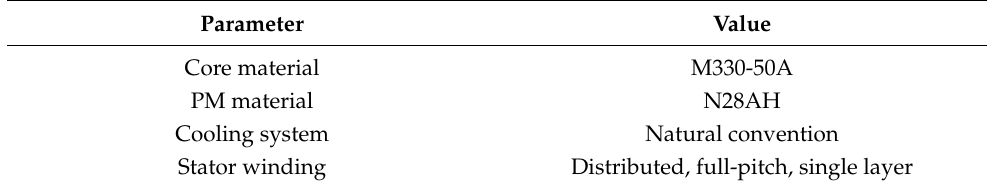
Table 3. Design choices and